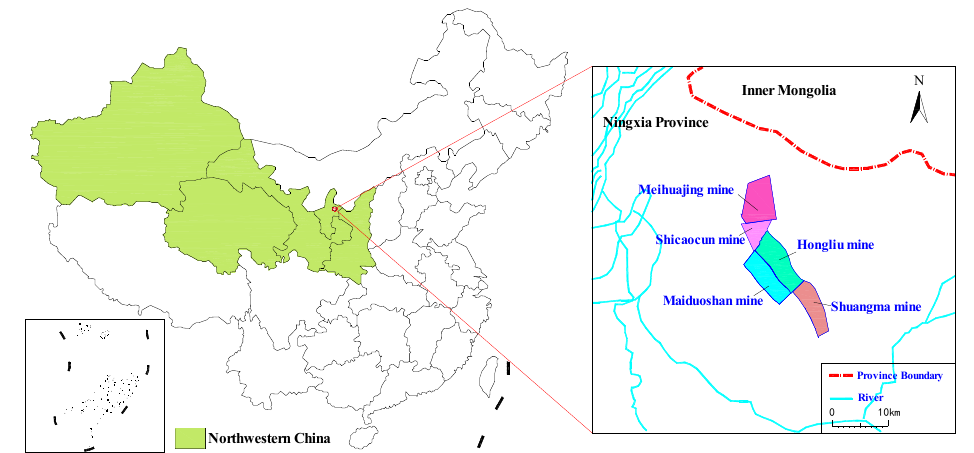
Figure 1. Geographical location of the study area.